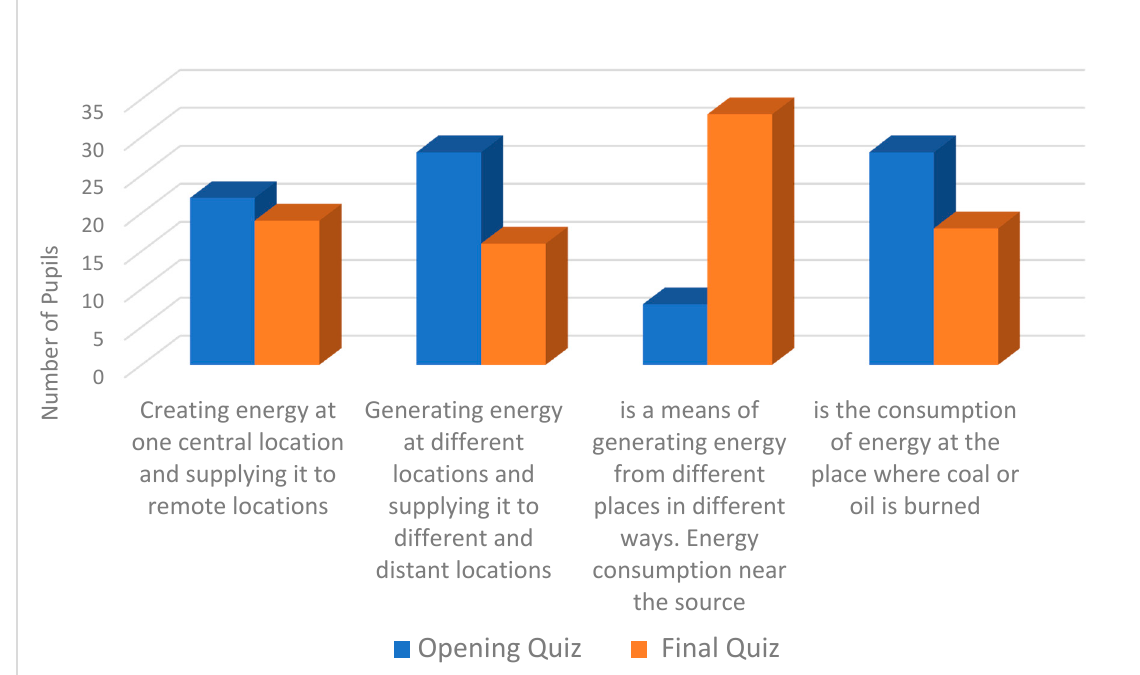
Figure 8. Results for the question “distributed energy systems are __”.